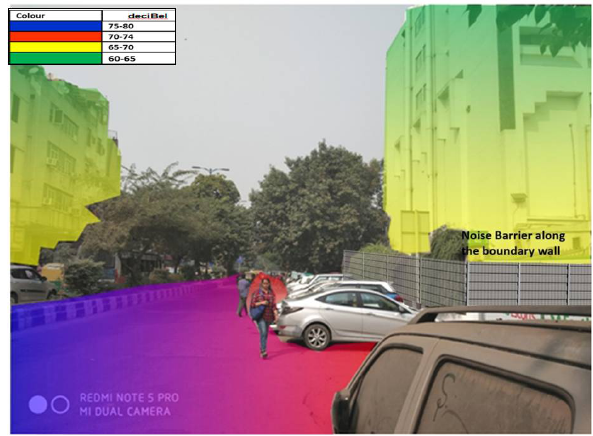
Figure 13: 3D noise mapping of Sukhdev Vihar after installation of noise